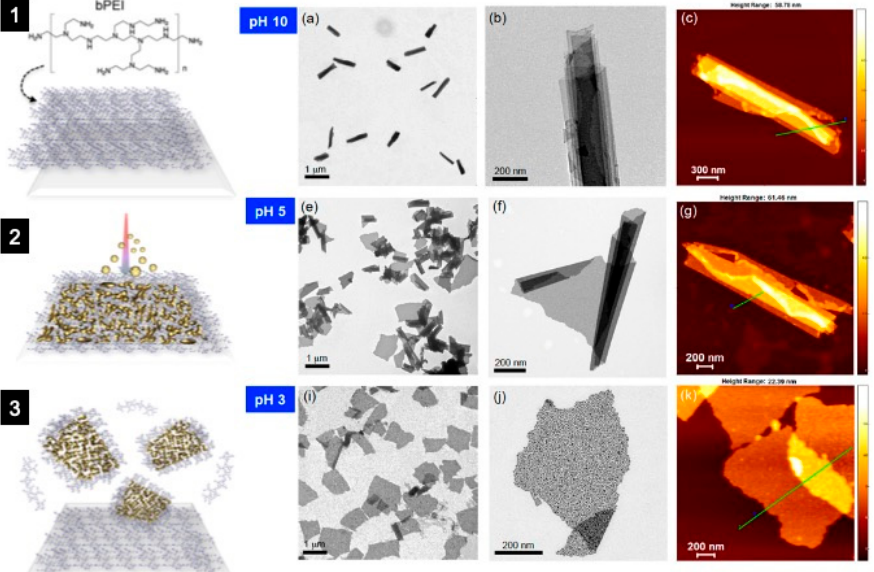
Figure 6. Schematic of the preparation and characterization of bPEI-Au NSHs. ( 1 ) The branched polyethyleneimine (bPEI) matrix was spin-coated onto a silicon wafer, ( 2 ) the Au film was deposited on bPEI/Si, and ( 3 ) the sample was dipped in methanol and exfoliated by ultrasonication. The pH- responsive behavior of the NSHs: ( a – c ) fully rolled NSHs at pH 10, ( e – g ) partially unrolled NSHs at pH 5, and ( i – k ) unrolled flat NSHs at pH 3. ( a , e , i ) TEM images showing rolled, partially unrolled, and fully unrolled NSHs, respectively. The scrolls are linear with no fragmentation. Higher-magnification TEM images showing controlled unrolling from ( b ) rolled to ( f ) partially unrolled and to ( j ) unrolled NSHs. ( c , g , k ) AFM topography images, consisting of the TEM data. Adapted with permission from Ref. [69]. Copyright 2014, American Chemical Society.